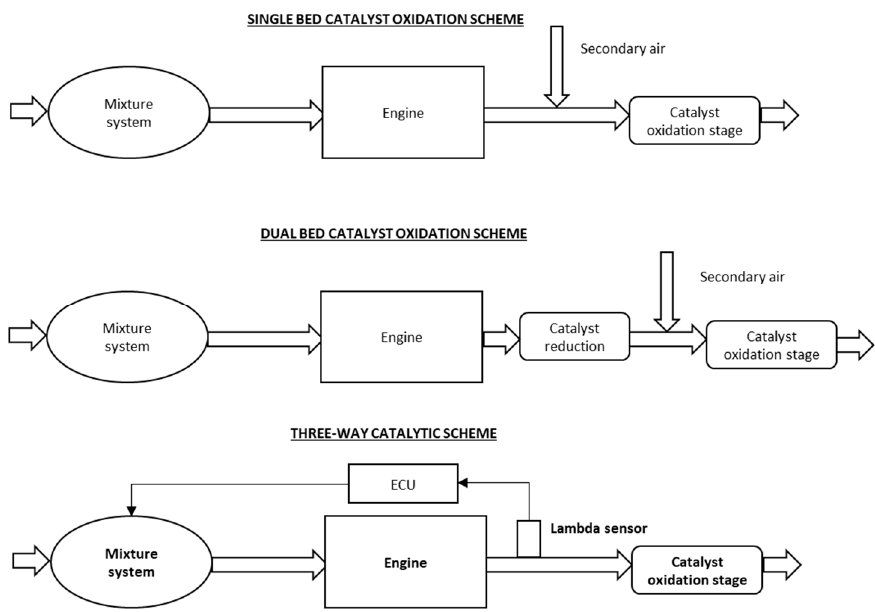
Figure 8. Installation of different types of catalytic converter systems. Adapted from [51].